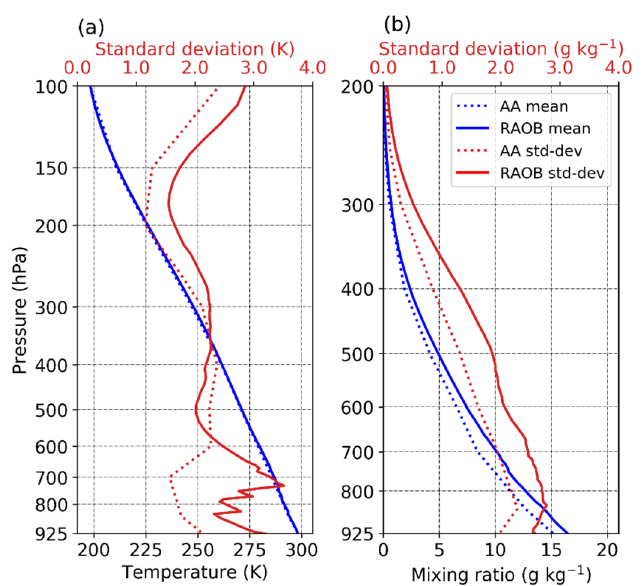
Figure 2. Vertical profiles of the mean (in blue) and standard deviation (in red) of ( a ) temperature and ( b ) water vapor mixing ratio from 20 June to 31 July in the years 2011 to 2016. Values of AIRS/AMSU (AA) are shown as dashed lines and radiosonde observations (RAOB) as solid lines.